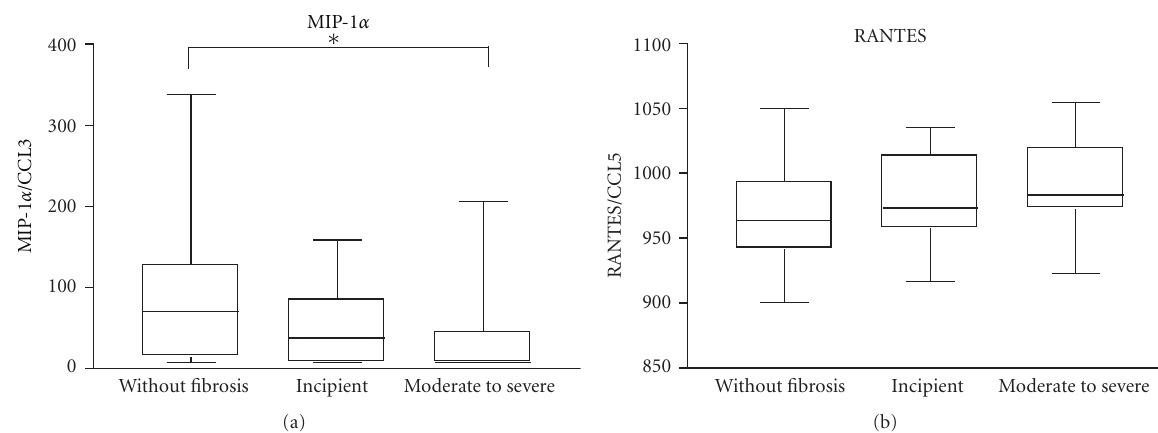
Figure 2: Serum chemokine levels in schistosomiasis individuals with di ff erent degrees of periportal fibrosis: (first box) individuals without fibrosis ( n = 30), (second box) incipient fibrosis ( n = 25), and (third box) moderate to severe periportal fibrosis ( n = 17). Levels of MIP-1 α and RANTES were determined by sandwich ELISA technique. Horizontal lines represent the median values, boxes represent the 25th to the 75th percentiles, and vertical lines represent the 10th to 90th percentiles. Asterisks indicate statistically significant di ff erences ( P < 0 . 05; ANOVA).